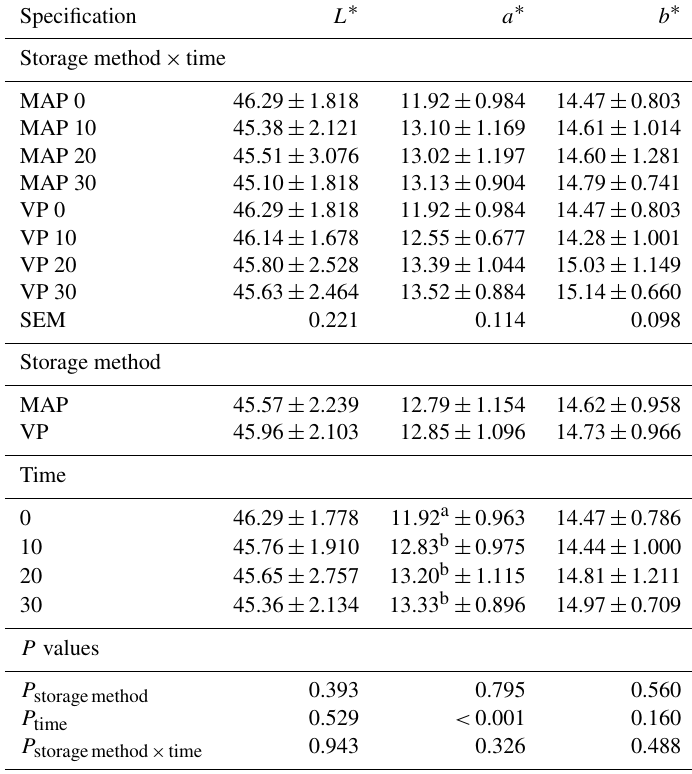
Table 4. Effect of vacuum packaging and modified atmosphere packaging on the meat color of lamb meat during storage at 4 ◦